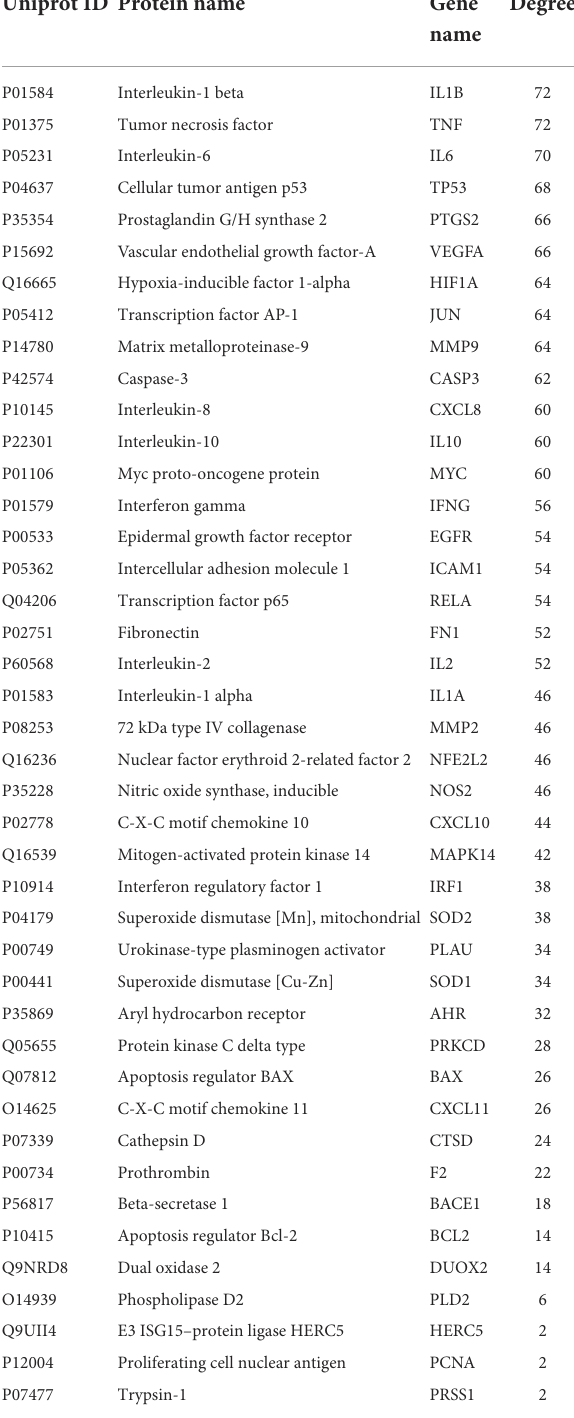
TABLE 2 Information on 42 potential target gene-associated